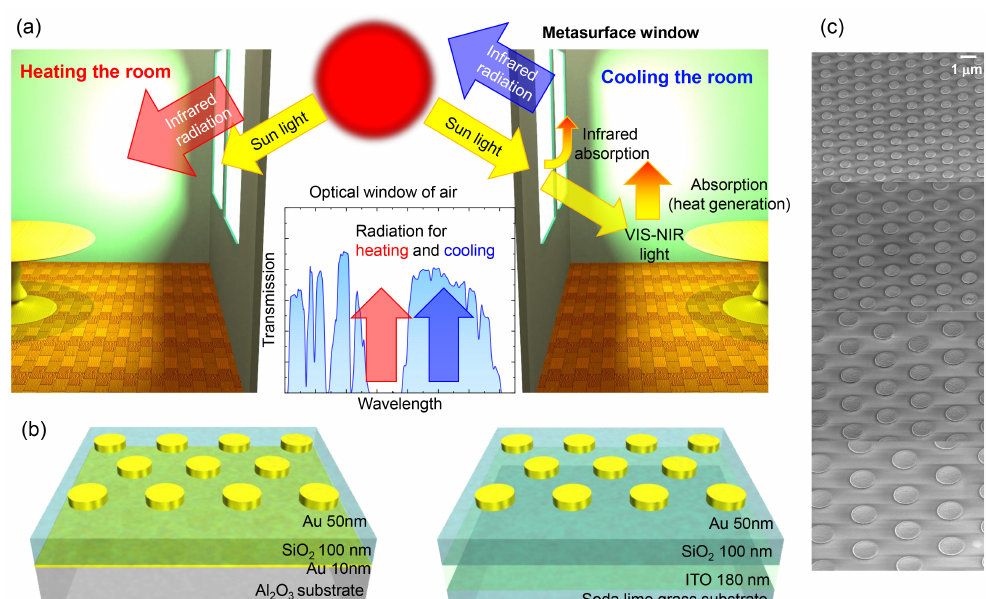
Figure 1. ( a ) Schematic illustration of passive control of energy flow in visible and near-IR trans- parency windows for the radiative cooling (right) and MIR absorptive metasurface for radiative heating (left). ( b ) Design of required metasurfaces investigated in this study: transparency at visi- ble and absorbance (emittance) at the MIR spectral range for energy-valve windows. ( c ) Scanning electron microscopy (SEM) images of metasurfaces made of discs with 700 nm, 1000 nm, 1300 nm, 1700 nm diameters; SEM images were taken at tilted 45 ◦